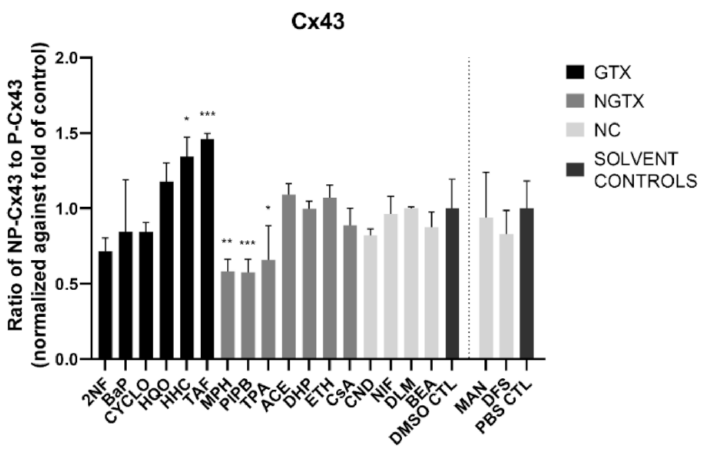
Figure 8. Ratio of the non-phosphorylated (NP-Cx43) isoforms against the two phosphorylated isoforms of Cx43 (P-Cx43). Human hepatoma HepaRG cells ( n = 3 and N = 1) were exposed to (non)- carcinogenic chemicals for 72 h. Densiometric quantitative data were obtained via Image Lab 6.0.1 software (Bio-Rad, Hercules, CA, USA). Data were normalized to the total protein loading (Figure S9) and a ratio of NP-Cx43 to P-Cx43 was calculated per compound. The ratios were normalized to the fold change of their respective solvent control (DMSO CTL or PBS CTL). Significant difference compared to the solvent control was calculated with a parametric one-way ANOVA followed by a Dunnett’s post-hoc test to correct for multiple comparisons. Data are expressed as mean ± standard deviation with * p ≤ 0.05 ** p ≤ 0.01 and *** p ≤